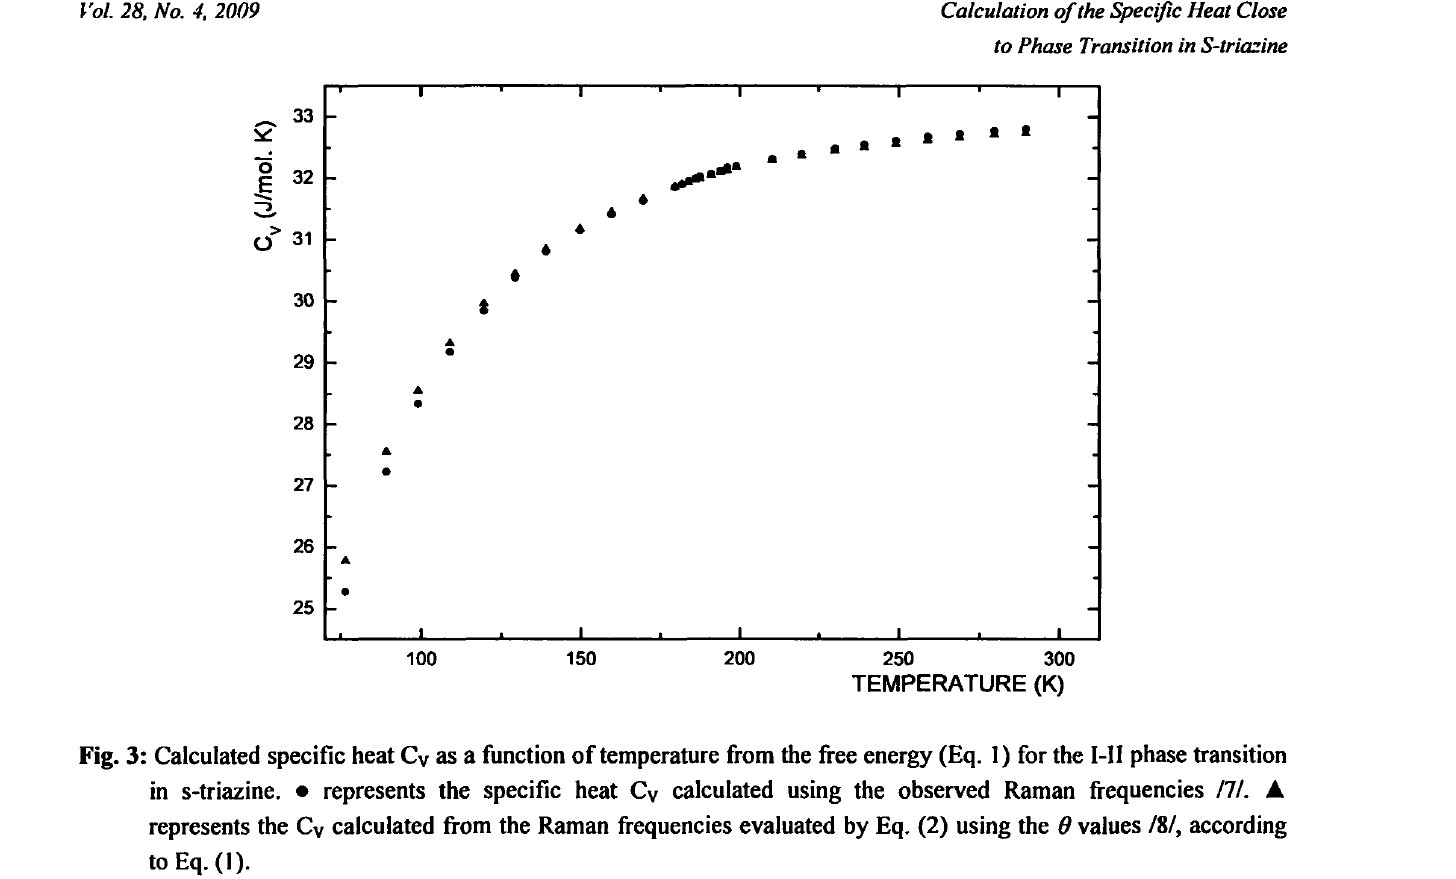
Fig. 3: Calculated specific heat C as a function of temperature from the free energy (Eq. 1) for the I-1I phase transition v in s-triazine. · represents the specific heat C calculated using the observed Raman frequencies /?/. A v represents the C calculated from the Raman frequencies evaluated by Eq. (2) using the θ values /8/, according v toEq.